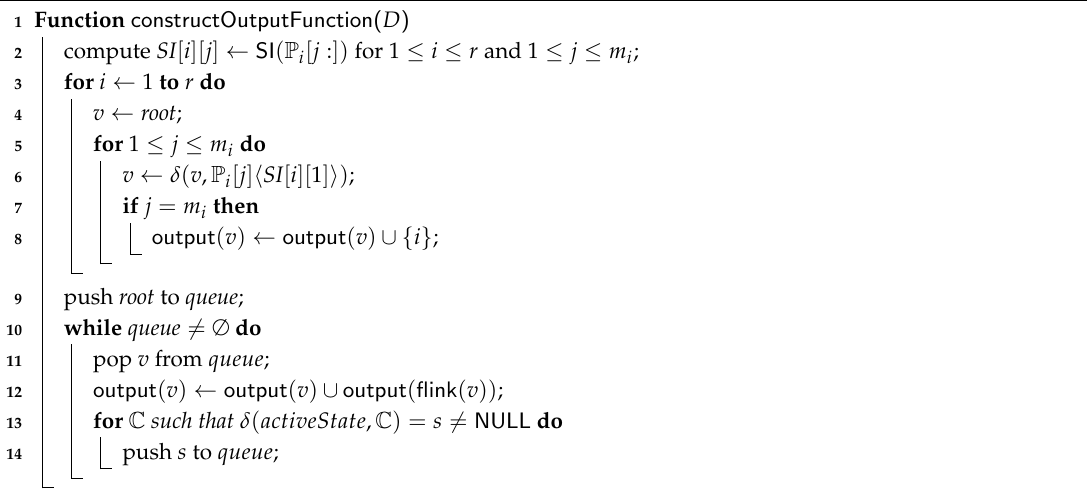
Algorithm 5: Multi-track AC-automaton output function construction algorithm.